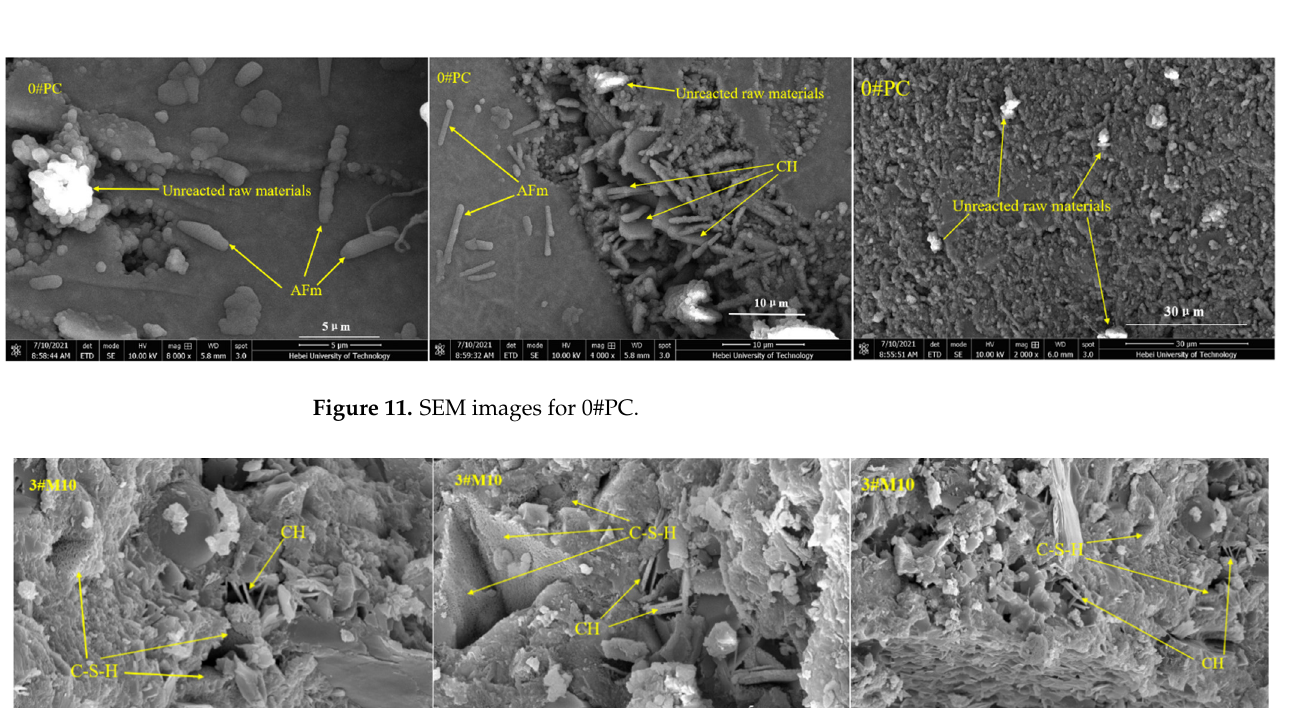
Figure 10. SEM images for 0#M10; ( a ) and ( b ) are SEM images of 0#M10.